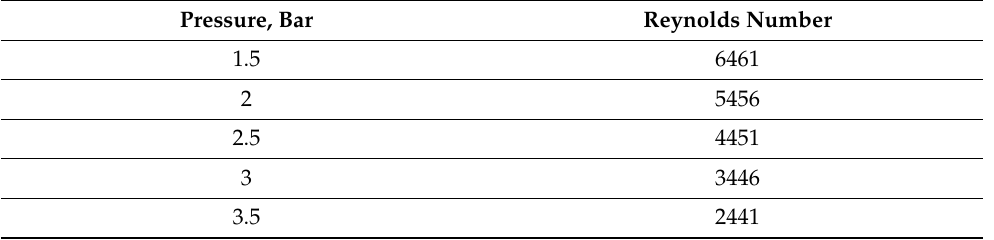
Table 3. The results of calculating the Reynolds number for different modes of water flow in the pipe. Pressure, Bar pipe.